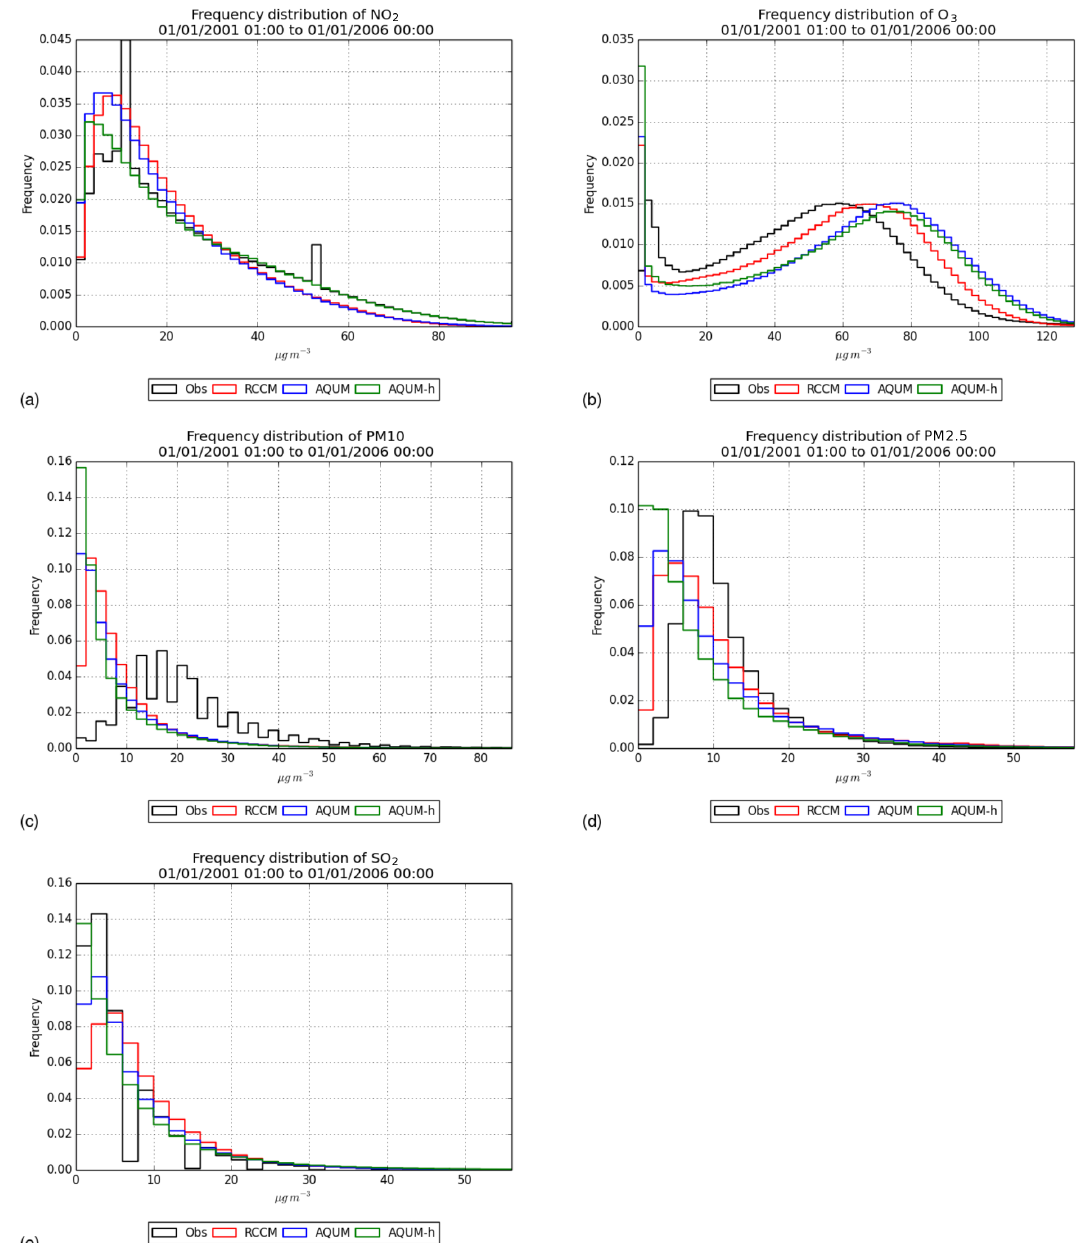
Figure 4. Frequency distribution of the main pollutants: (a) NO 2 , (b) O 3 , (c) PM 10 , (d) PM 2 . 5 , and (e) SO 2 . Observations are shown in black, RCCM in red, AQUM in blue, and AQUM-h in green.